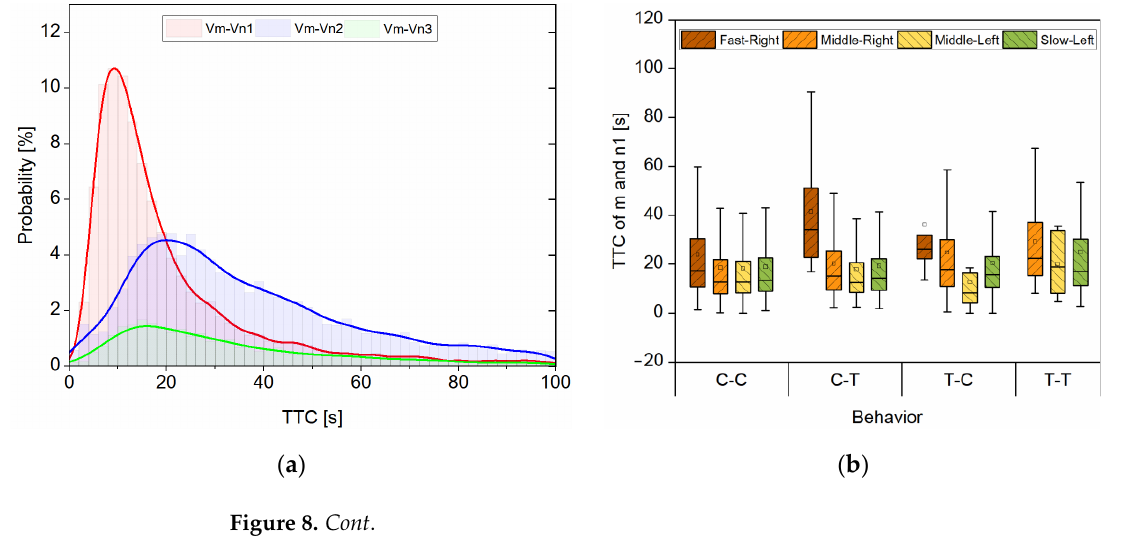
Figure 7. ( a ) Probability distribution of ∆D; ( b ) ∆D between m and n1; ( c ) ∆D between m and n2; ( d ) ∆D between m and n3.